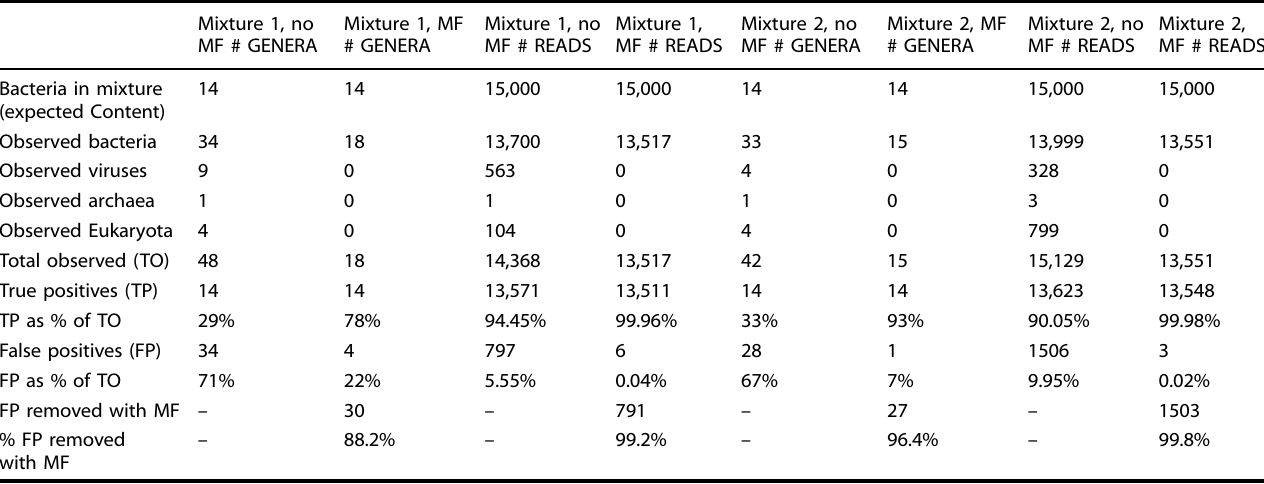
Table 1. Accuracy of microbial identi fi cation using two in silico constructed simulated food mixtures. Mixture 1, no MF #